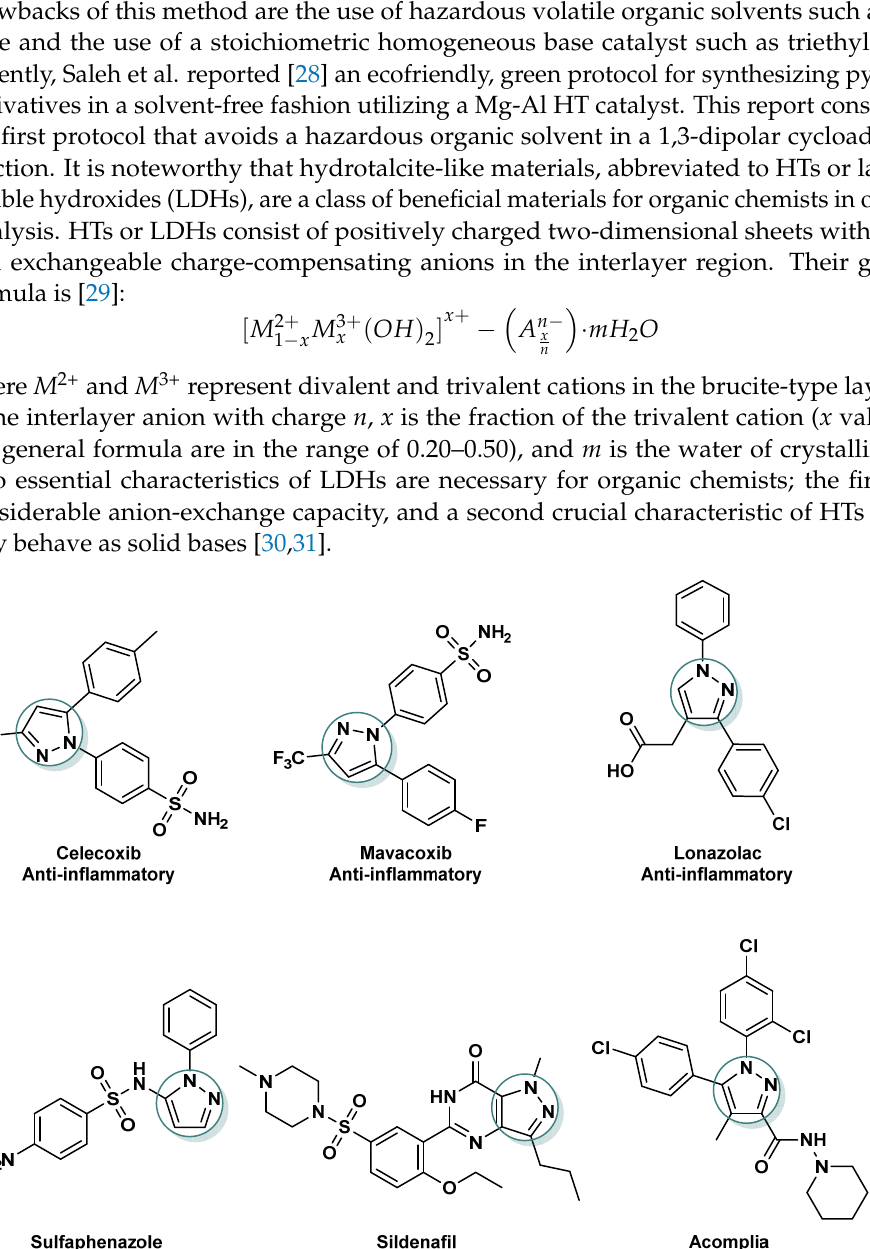
(1) where M 2+ and M 3+ represent divalent and trivalent cations in the brucite-type layers, A is the interlayer anion with charge n , x is the fraction of the trivalent cation ( x values in the general formula are in the range of 0.20–0.50), and m is the water of crystalliza- tion. Two essential characteristics of LDHs are necessary for organic chemists; the fi rst is a considerable anion-exchange capacity, and a second crucial characteristic of HTs is that they behave as solid bases [30,31].